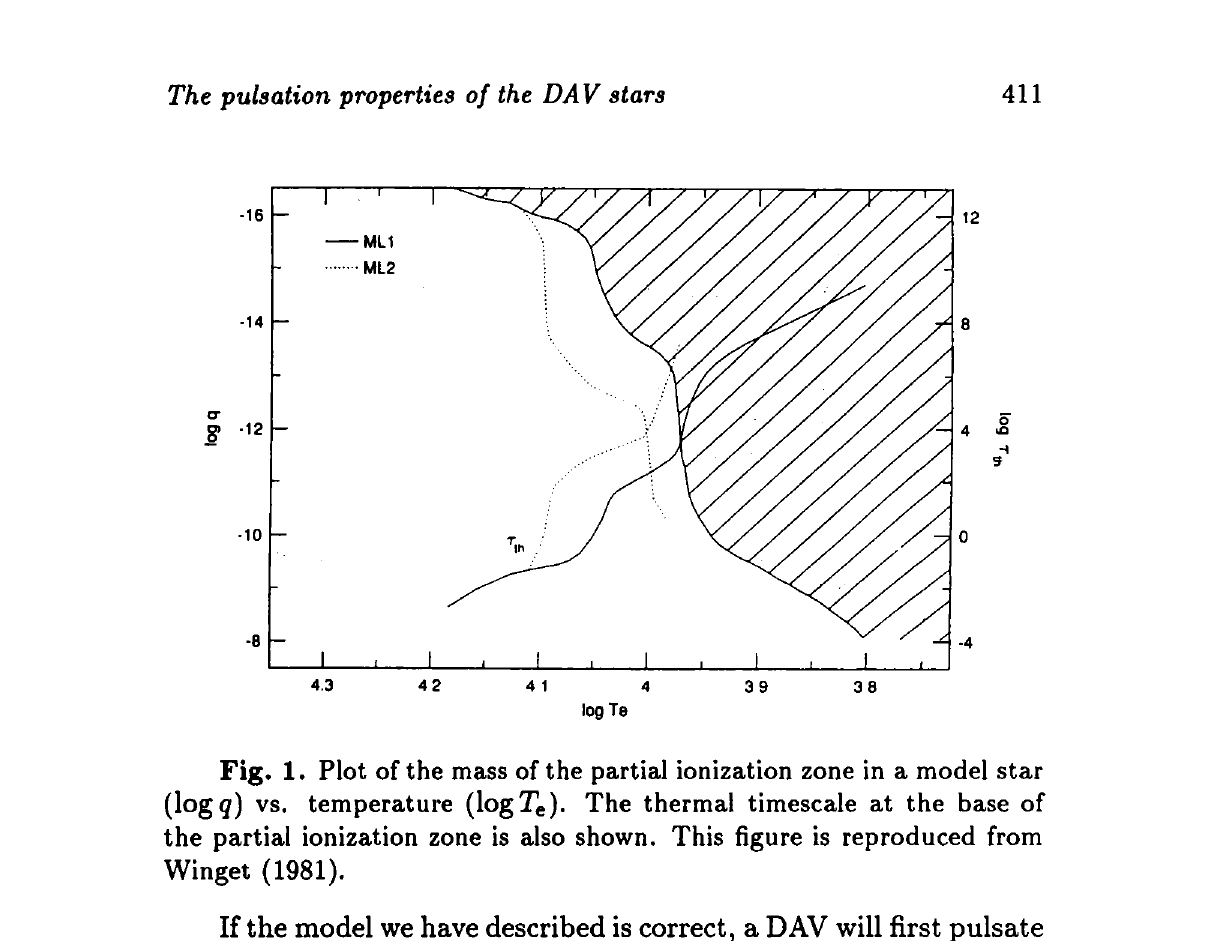
Fig. 1. Plot of the mass of the partial ionization zone in a model star (logg) vs. temperature (logT e ). The thermal timescale at the base of the partial ionization zone is also shown. This figure is reproduced from Winget